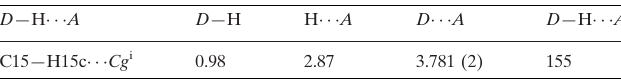
Hydrogen-bond geometry (A˚ , (cid:3) ). Cg is the centroid of the C4–C9